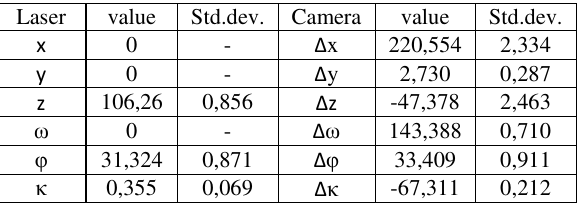
Table 1: Calibration Results. Positions are given in mm and orientations as angles in degrees around the x ( ω ), y ( φ ) and z ( κ ) axes. Camera position and orientation is given relative to the laser.